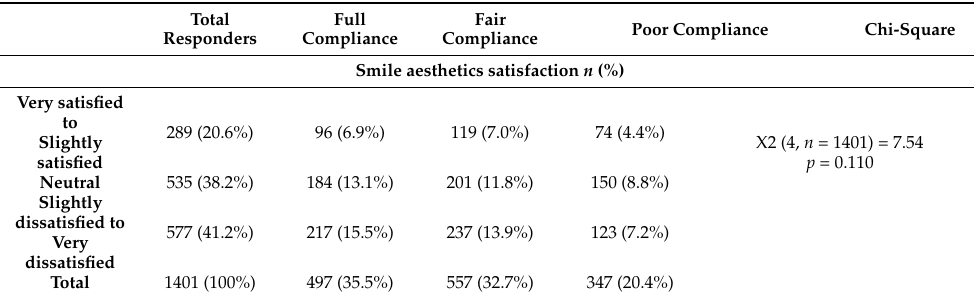
Table 4. Patient compliance and smile aesthetics satisfaction.